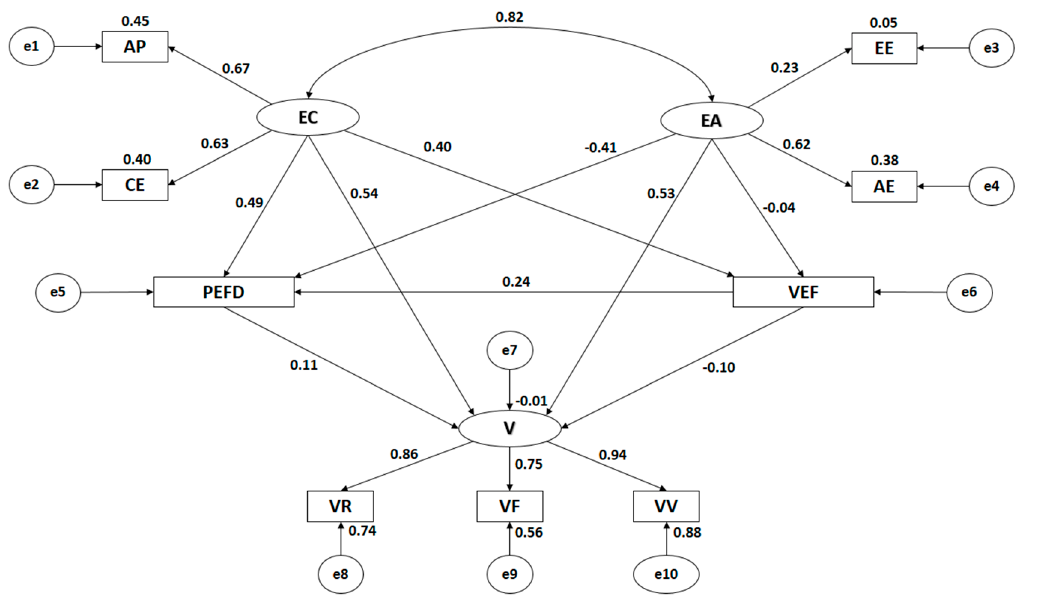
Figure 2. Structural equation model for individuals who regularly engaged in physical